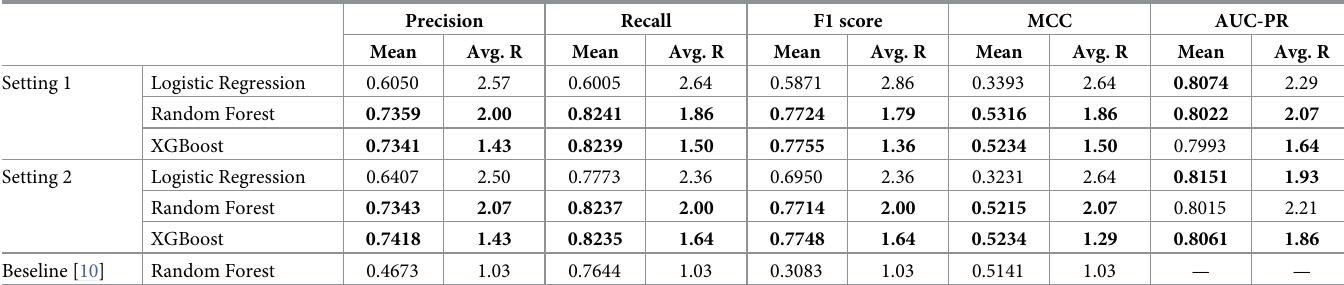
Table 4. Classification results for both settings with the two best performing classifiers shown in bold